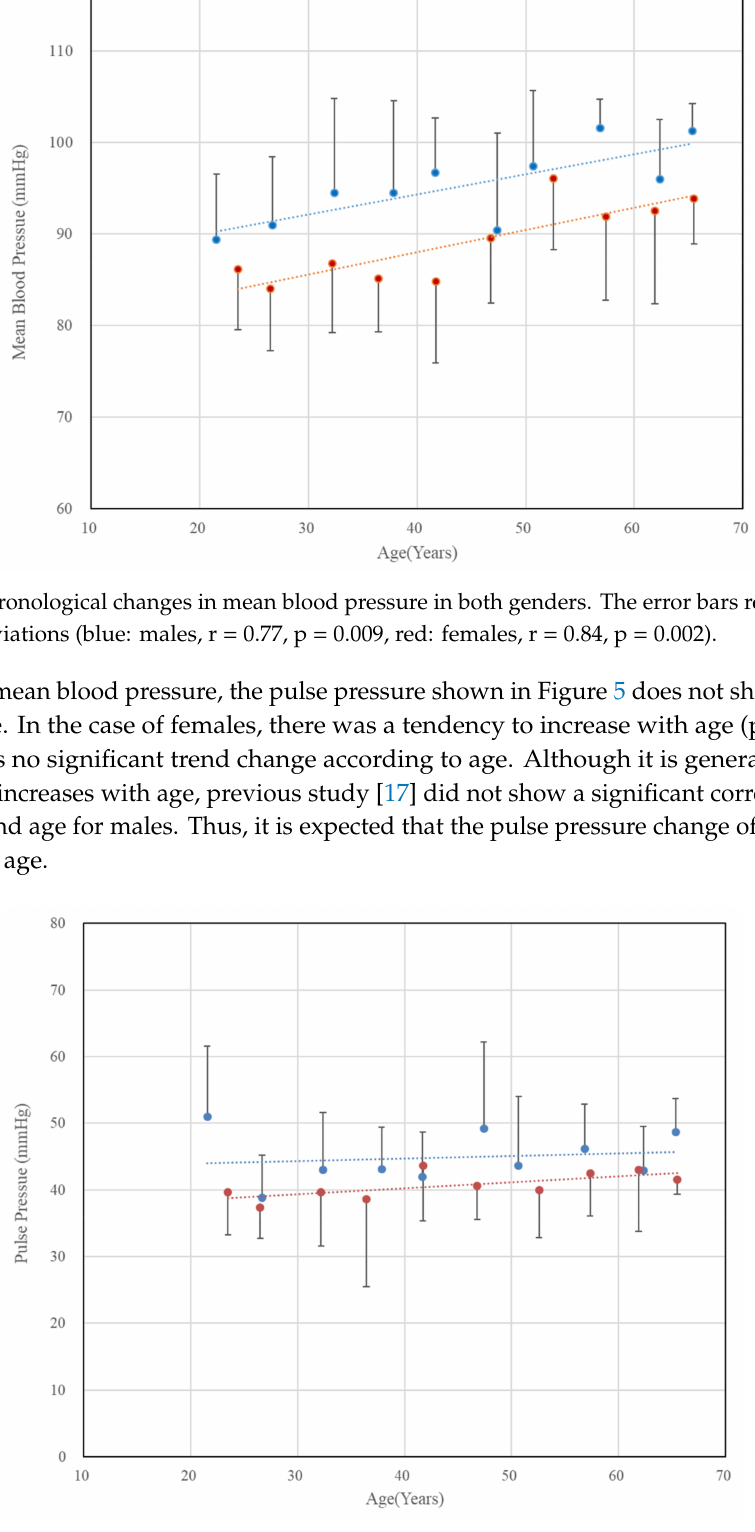
Figure 5. Chronological changes in pulse pressure (the di ff erence between systolic blood pressure and diastolic blood pressure) in both genders. The error bars represent the standard deviations (blue: males, r = 0.147, p = 0.685, red: females, r = 0.663, p =